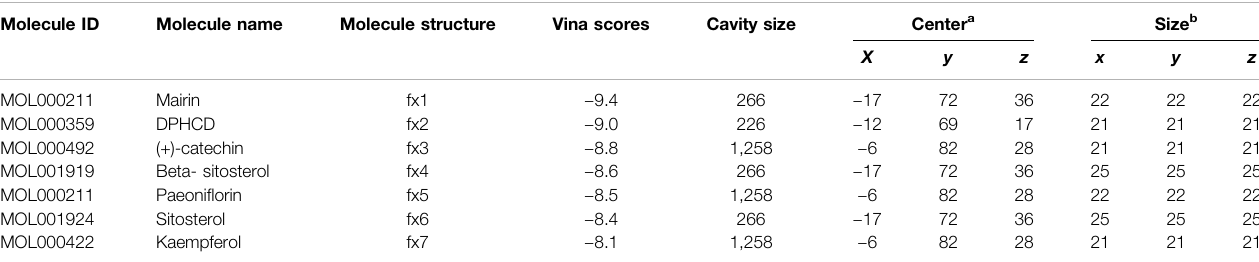
TABLE 4 | Molecular docking parameters and results of seven active ingredients in WP binding with TNF- α